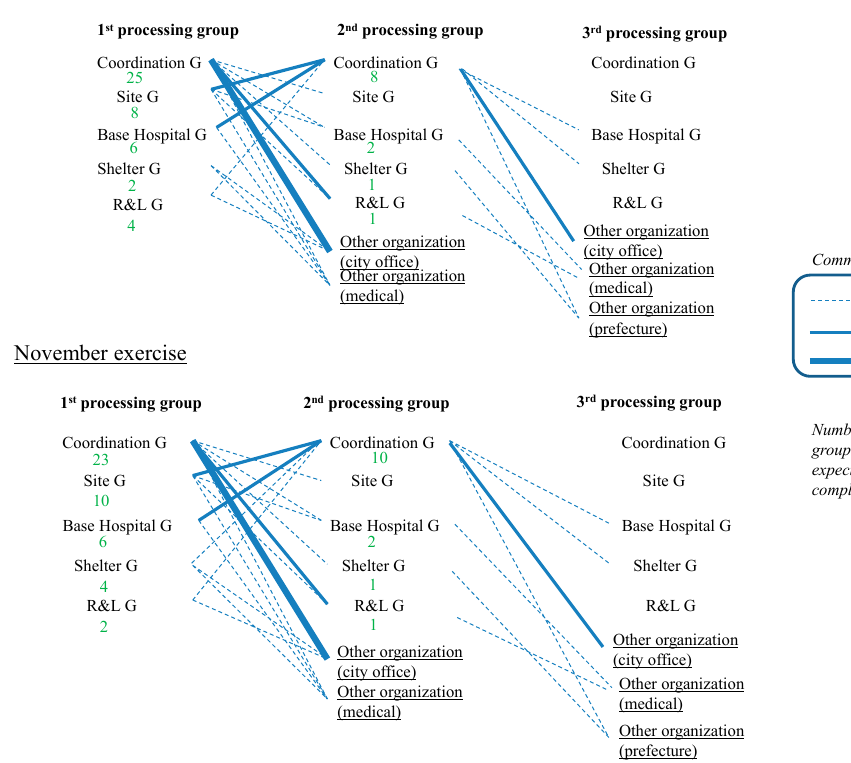
Figure 2. Communication networks of the two exercises.